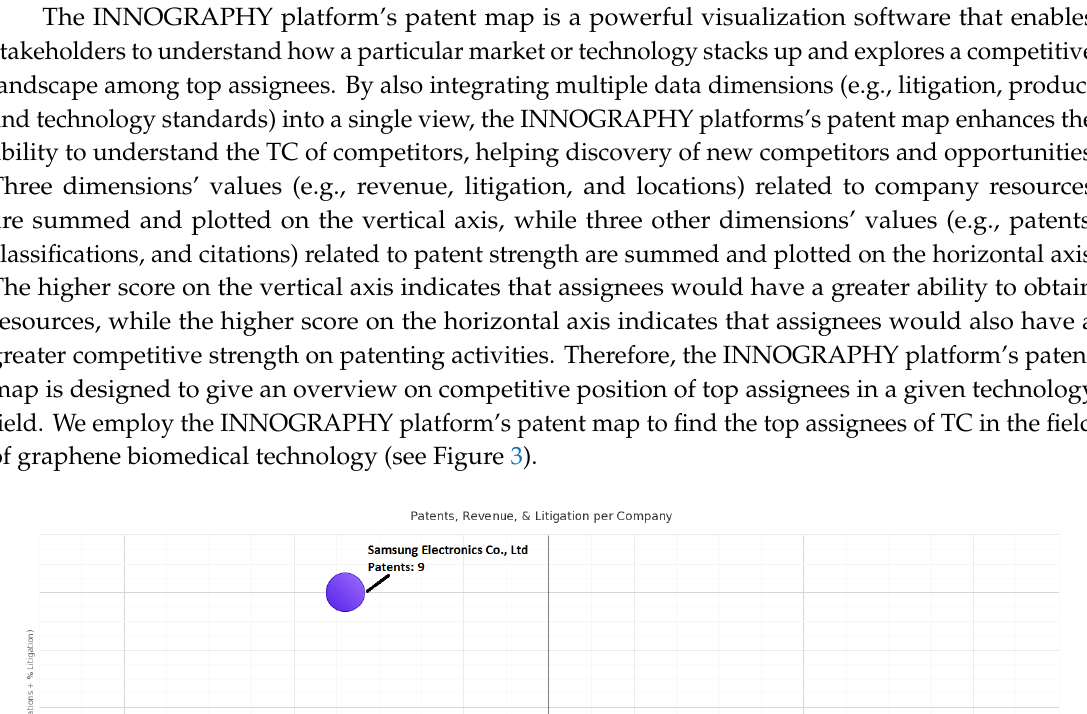
Figure 2. Annual trend of patent activities of graphene biomedical technology.